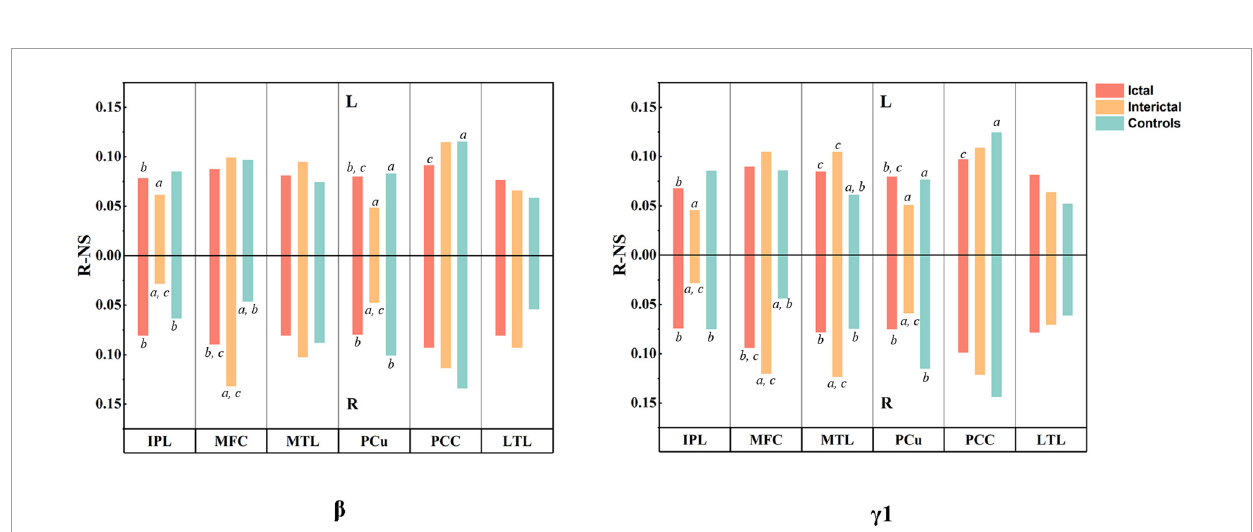
FIGURE5 Results of MEG connectivity analysis. The histogram shows the relative node strength of 12 DMN regions in beta and gamma1 bands. The upper half represents the left hemisphere and the lower half represents the right hemisphere. All values are mean. a P < 0.01 compared to Ictal, b P < 0.01 compared to Interictal, and c P < 0.01 compared to